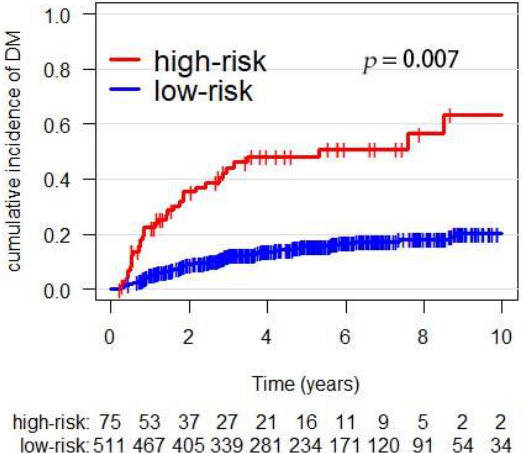
Figure 2. The incidence of DM in the DM risk subgroups.